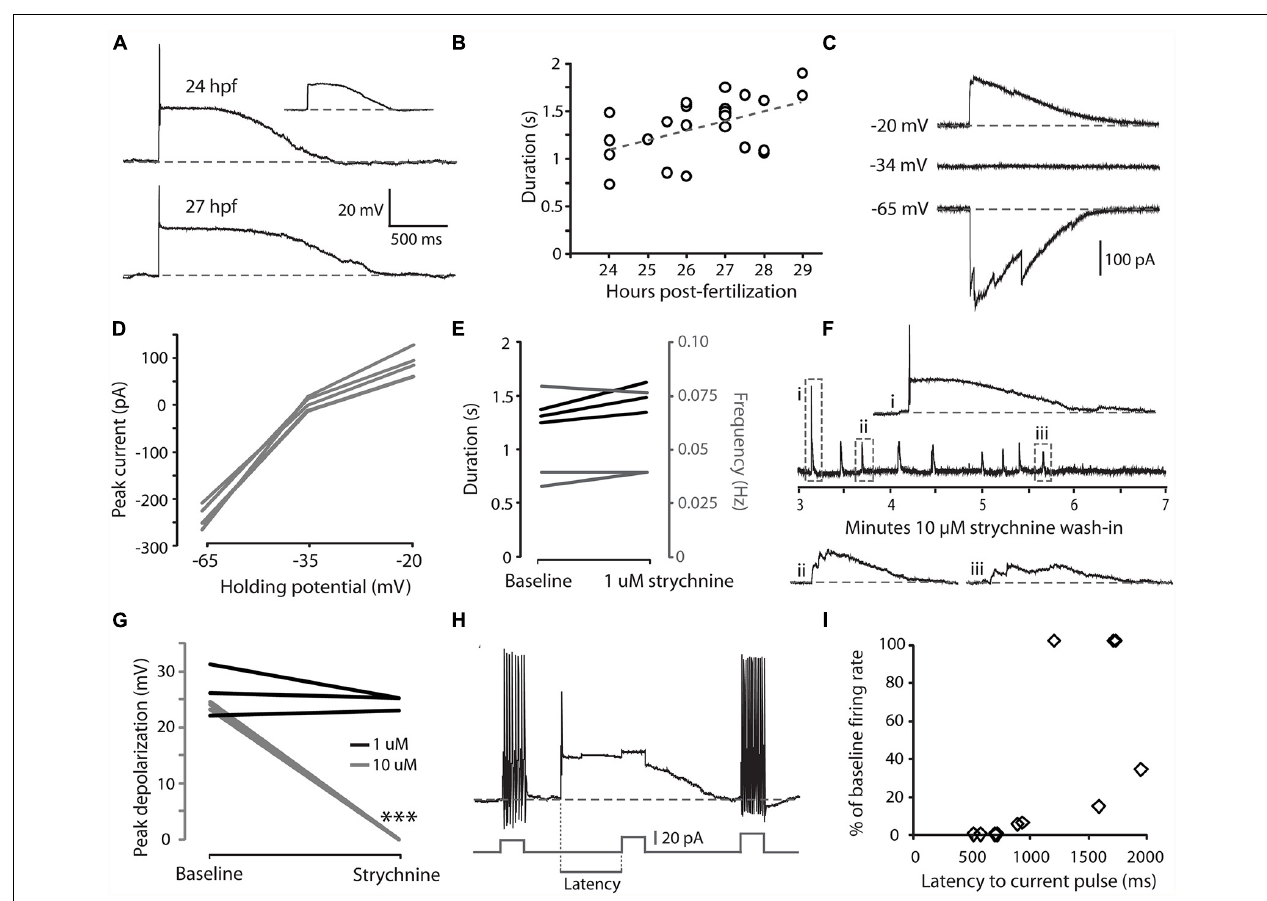
FIGURE 2 | Embryonic CoPAs show spontaneous activity in the form of a long-lasting depolarization that has low strychnine sensitivity and shunts excitation. (A) Large upper trace, representative example of a whole-cell current-clamp recording of a spontaneous depolarizing event in a CoPA interneuron from a 24 hpf embryo that often triggered a small action potential at the onset. Baseline is shown as a dashed gray line for reference and resting membrane potential is –60 ± 5 mV in this and all subsequent current-clamp recordings. Inset upper right, example of a spontaneous depolarizing event in the same neuron that does not produce an action potential (scaled to 50%). Lower trace, a spontaneous depolarizing event recorded from an older 27 hpf embryo. (B) A significant positive correlation was found between embryonic age and the duration of depolarizing events in CoPAs. Pearson’s correlation coefficient r = 0.49 ( p < 0.05; N = 25). The best linear fit is shown as a gray dashed line. (C) Representative whole-cell voltage-clamp recording from a CoPA neuron showing that the spontaneous currents are reversed at less negative holding potentials (–20 mV) compared to baseline (–65 mV) and that the net current is zero at –34 mV, the approximate chloride reversal potential. Timescale same as in (A) . (D) Average peak currents (not including initial spike) for CoPAs at three different holding potentials ( N = 4). (E) Line graph showing that